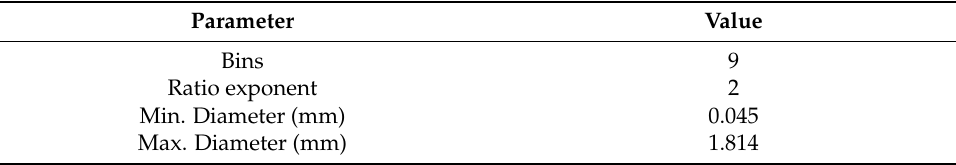
Table 1. Fragment size